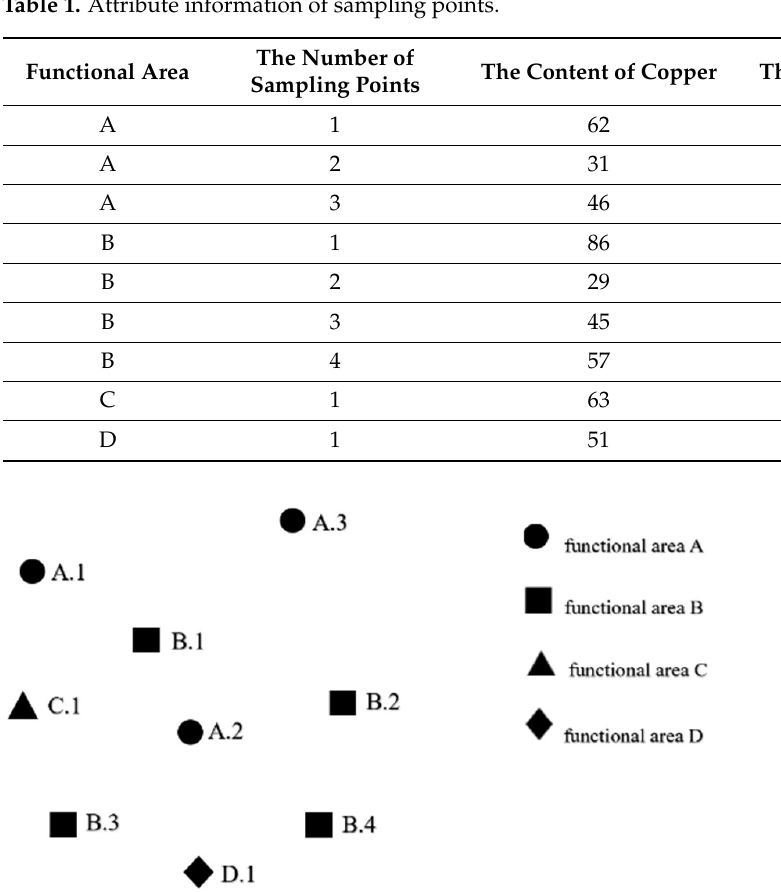
Table 1. Attribute information of sampling points.